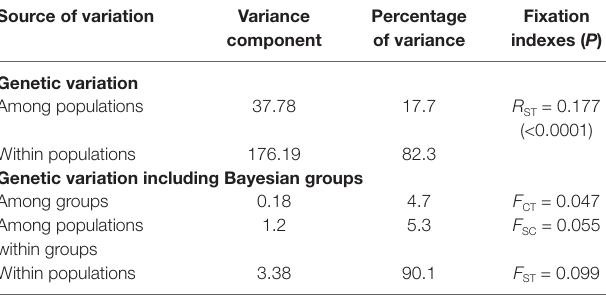
TABLE 4 | Results of the analysis of molecular variance (AMOVA) for Qualea grandiflora.